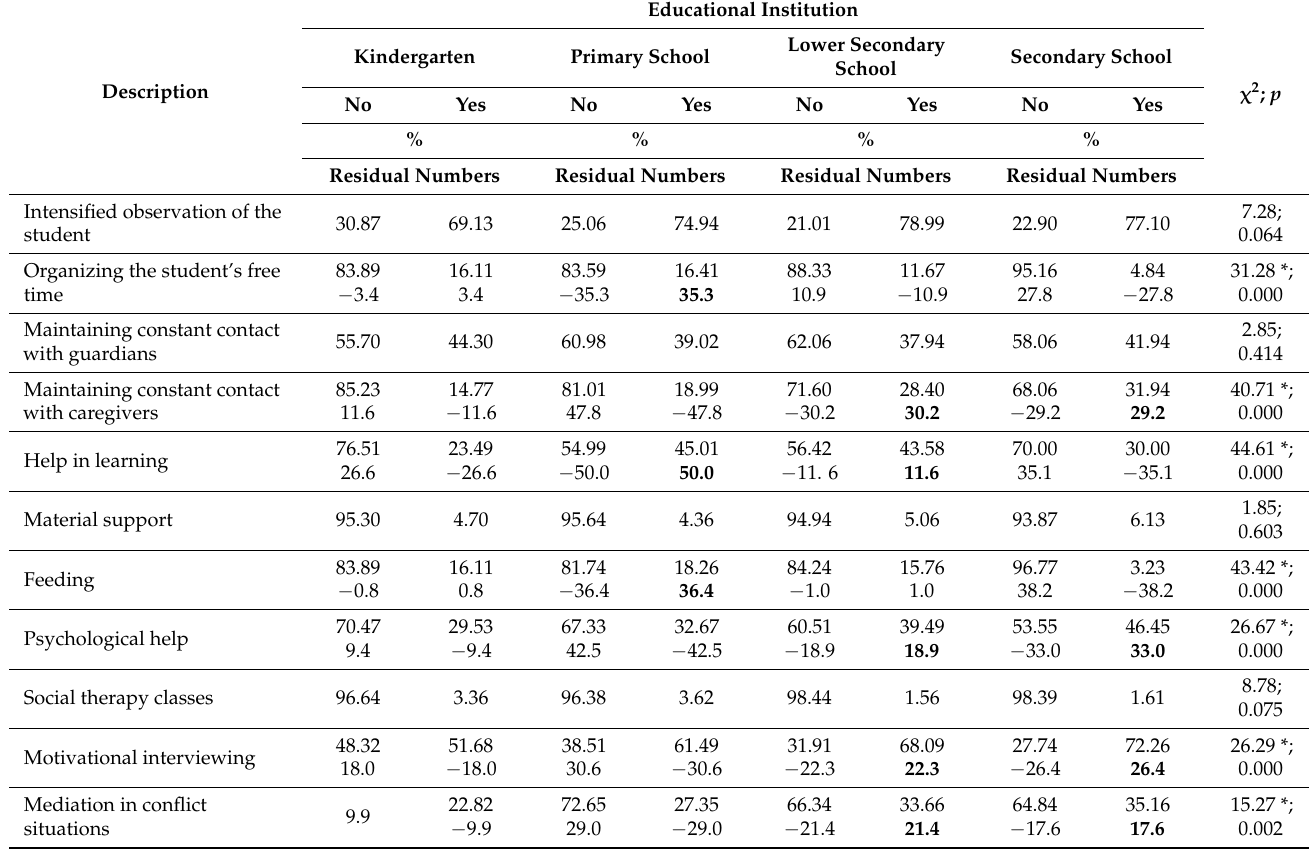
Table 4. The variety of activities undertaken in order to provide students with the necessary